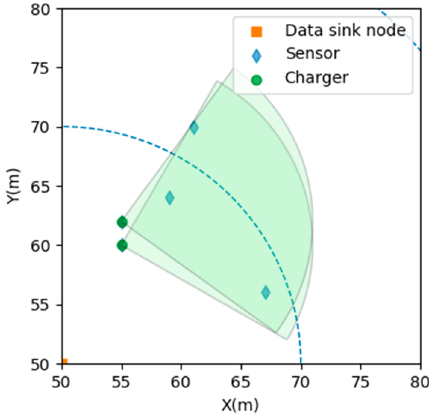
Figure 1. Covers all sensors with two chargers.